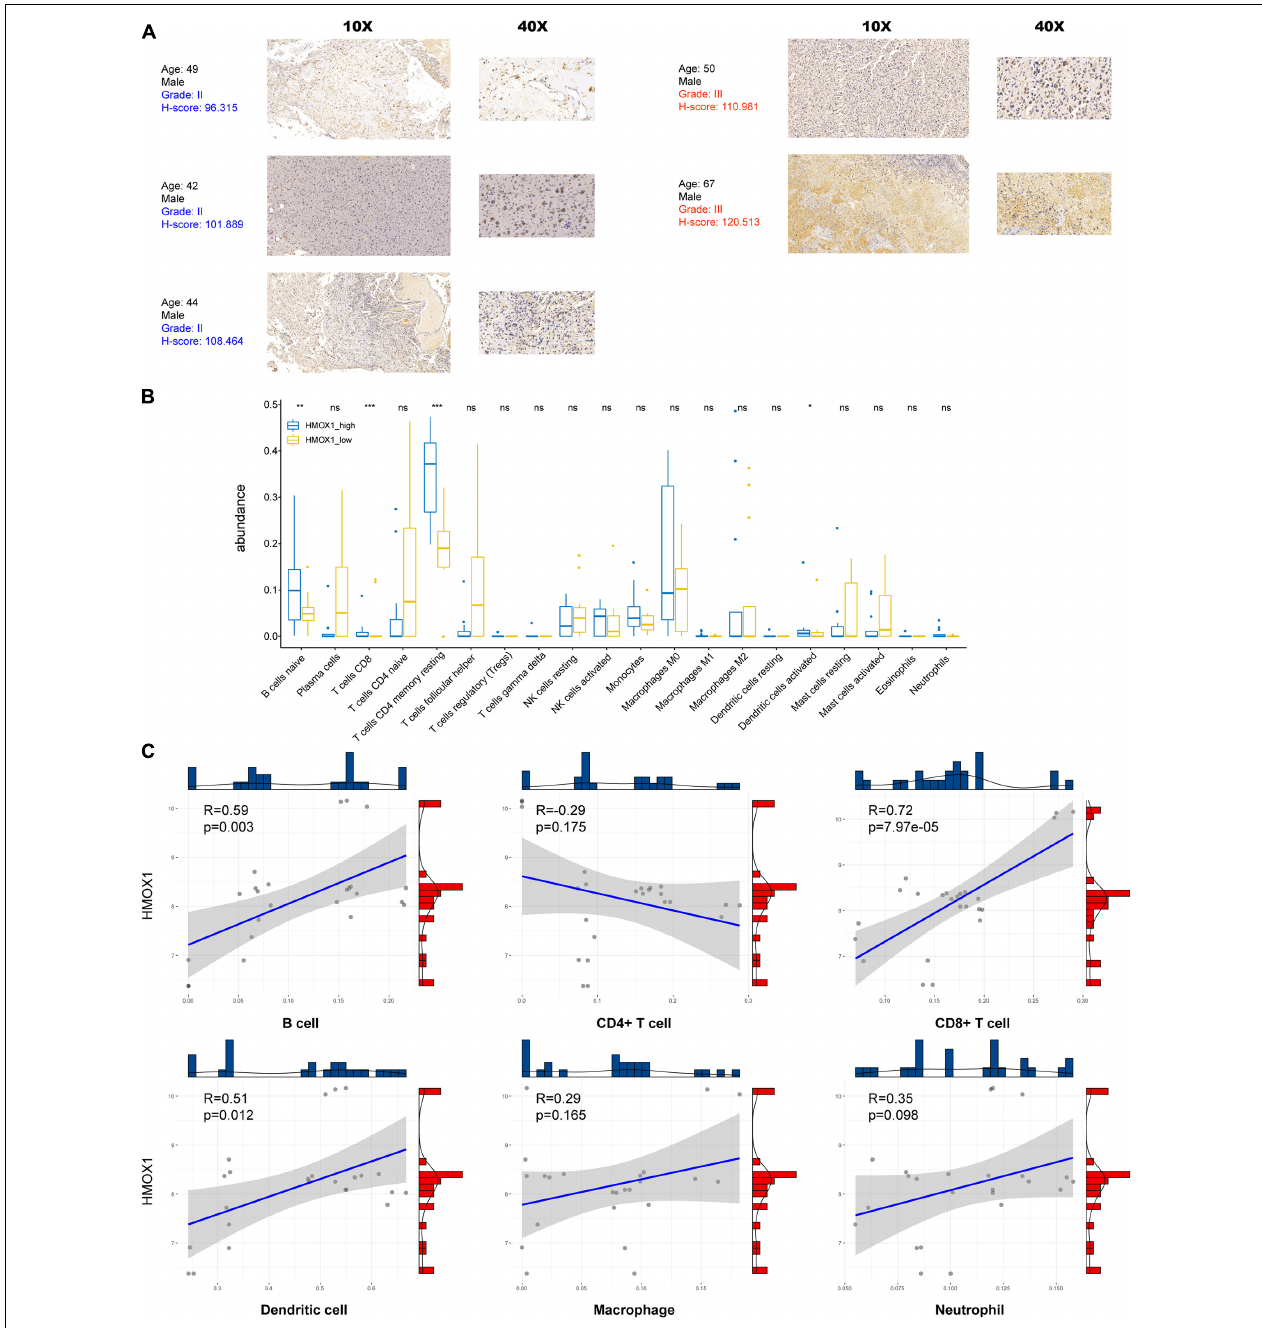
FIGURE 4 | Validation by using glioma samples from Xiangya Hospital. (A) Immunohistochemical staining results of five samples in Xiangya hospital. (B) The abundance of immune infiltrates between HMOX1 high and HMOX1 low groups in 24 glioma samples. (C) The correlations between HMOX1 expression and immune infiltrates in 24 glioma samples. * p < 0.05, ** p < 0.01, *** p < 0.001, ns, not significant.